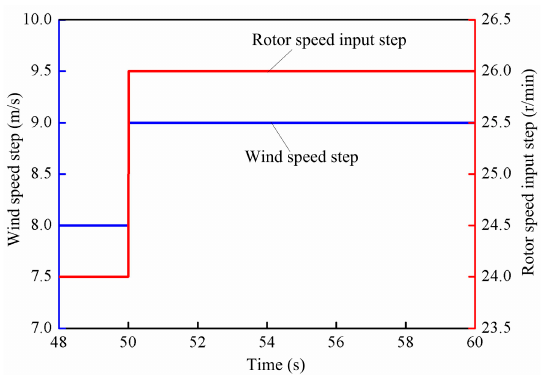
Figure 8. Wind speed step and rotor speed input step.